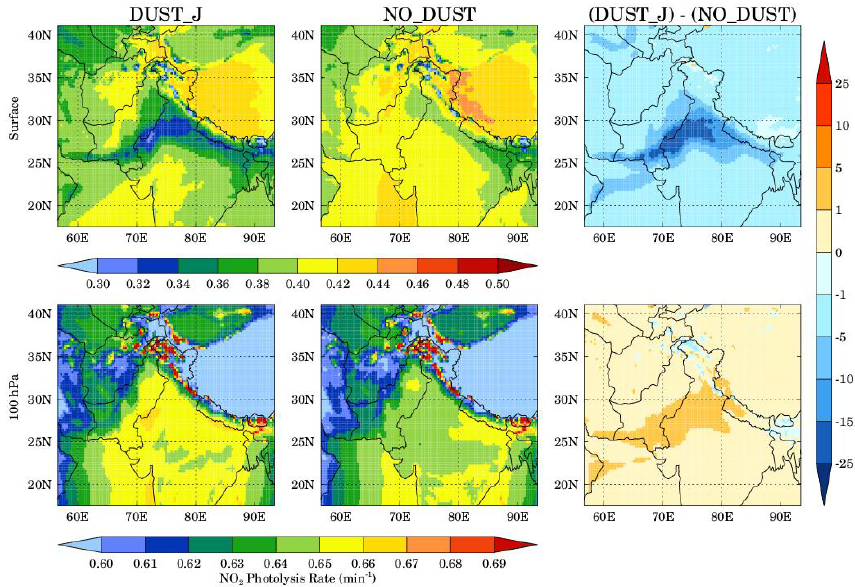
Figure 4. Spatial distributions of the WRF-Chem-simulated daytime (02:00–12:00UTC) NO 2 photolysis rate with (Dust_J) and without dust (No_Dust) at the surface (top panel) and 100hPa (bottom panel) during 17–22 April 2010 are shown. Percentage differences between Dust_J and No_Dust cases are also